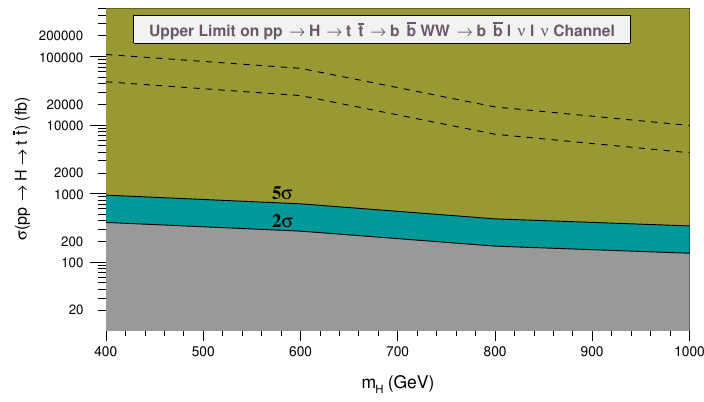
Figure 31 . Upper limit on (cid:27) ( pp channel. The solid (dashed) lines show the 2 (cid:27) -5 (cid:27) band on taking 0% (5%) systematic uncertainties.